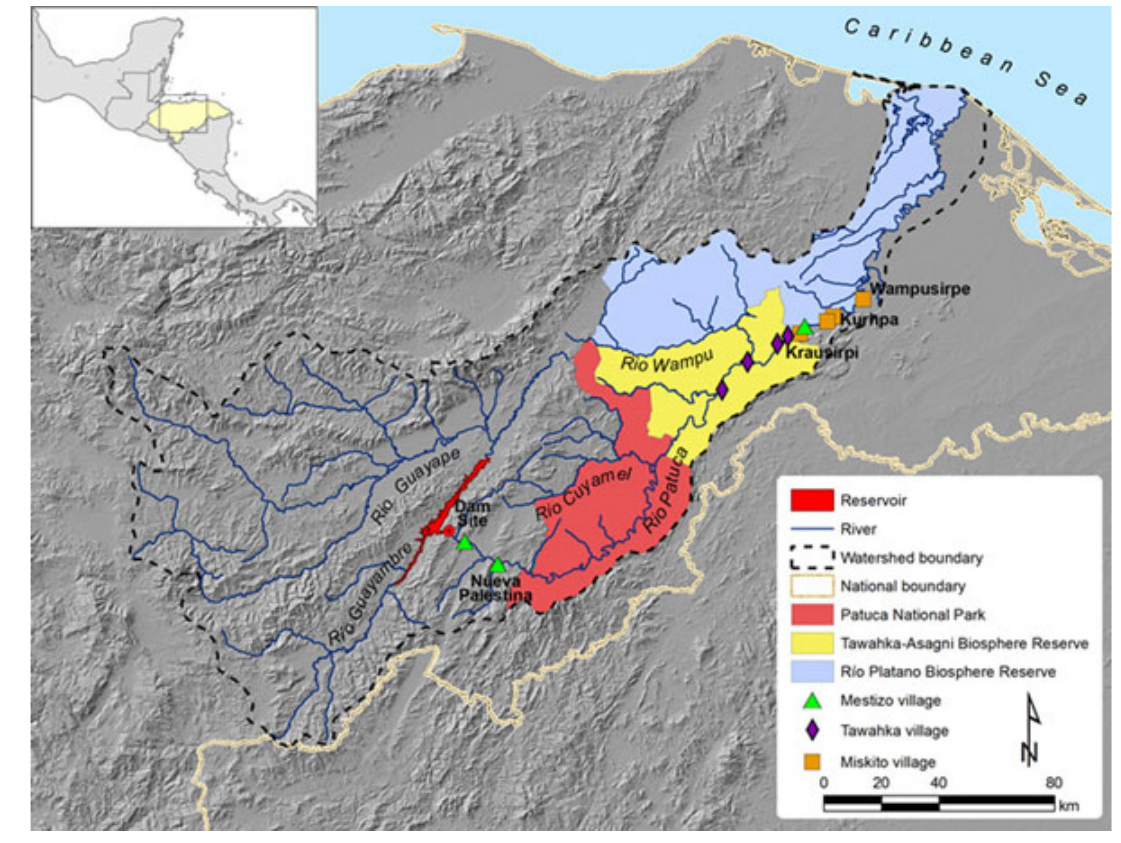
Fig. 1. The Patuca River and its location in the country of Honduras in Central America. The study reach stretched from just below the dam site near Nueva Palestina to the village of Kuhrpa in the coastal plain. The hydrological gauging site at Cayetano mentioned in the text was located just below the dam site, whereas the one at Kuhrpa was located at the village with the same